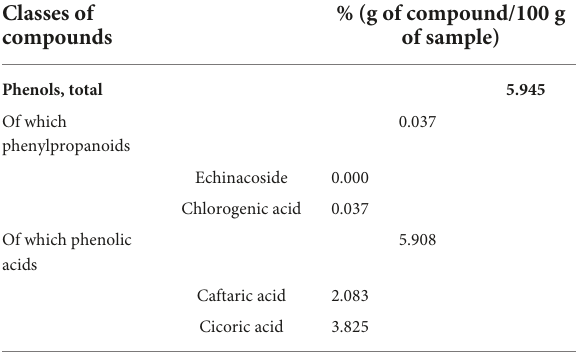
TABLE 1 Characterization of Echinacea purpurea extract.